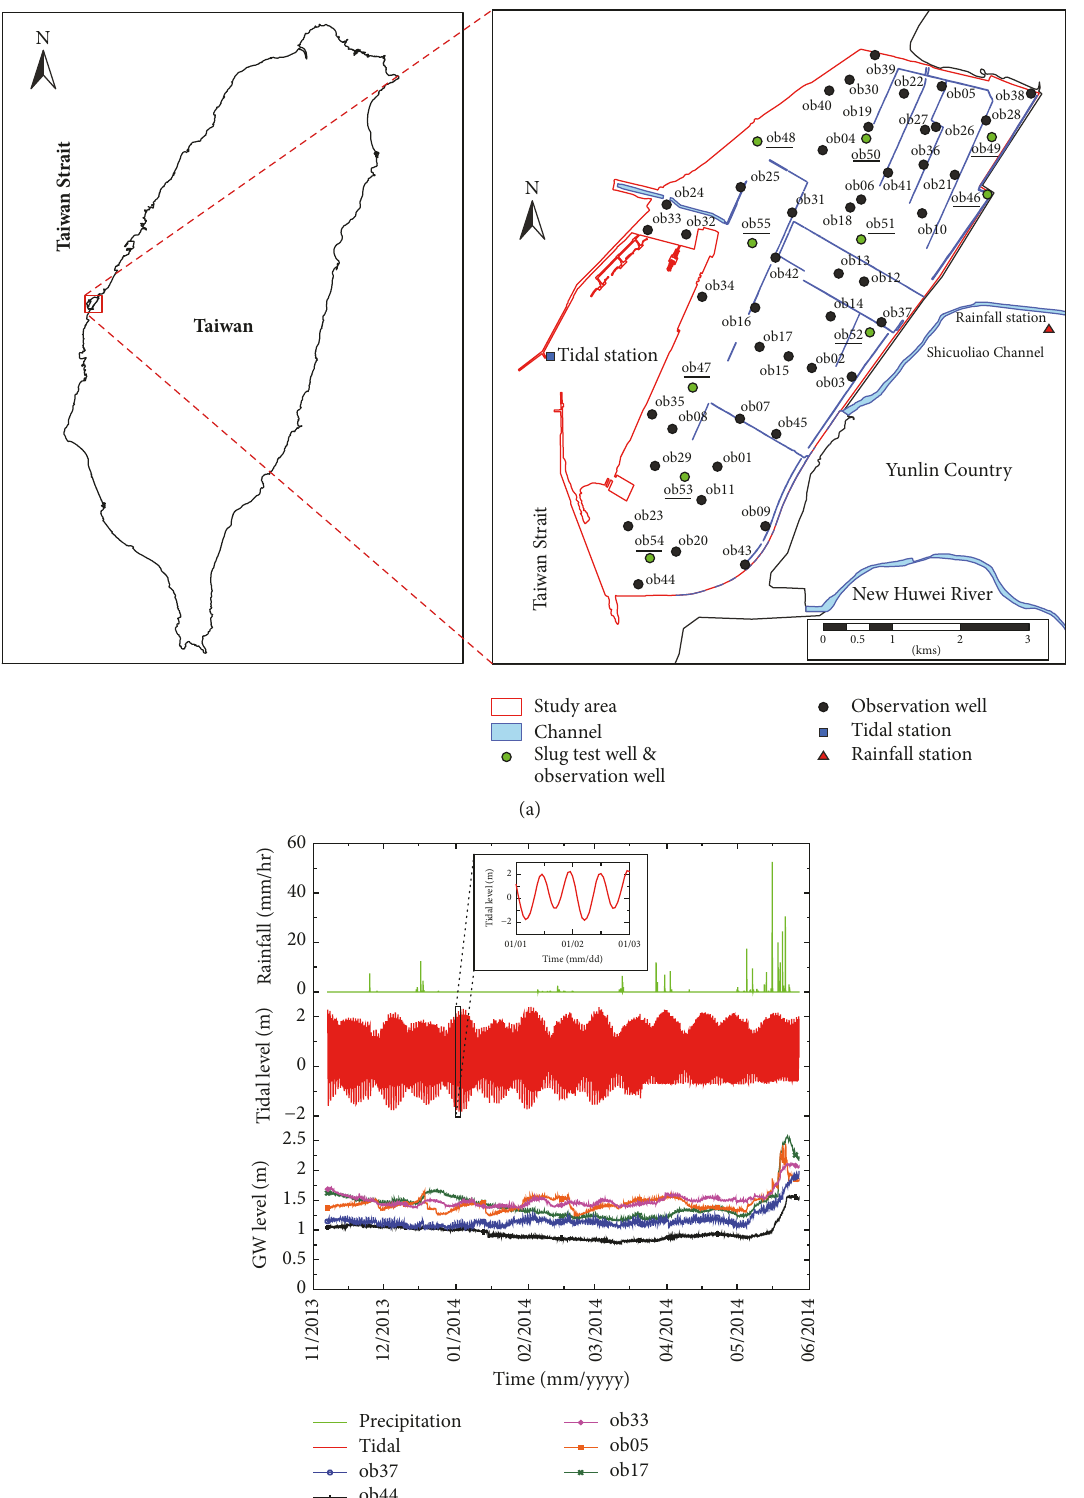
Figure 1: (a) Locations of the 55 observation wells (black and green circles), 10 of which belong to the slug test wells (green circles), a tidal station (blue square), and a rainfall station (red triangle); (b) long-term rainfall, tidal, and groundwater levels during the period 11/07/2013 ∼ 05/27/2014, and short-term tidal levels during the period 01/01/2014 ∼